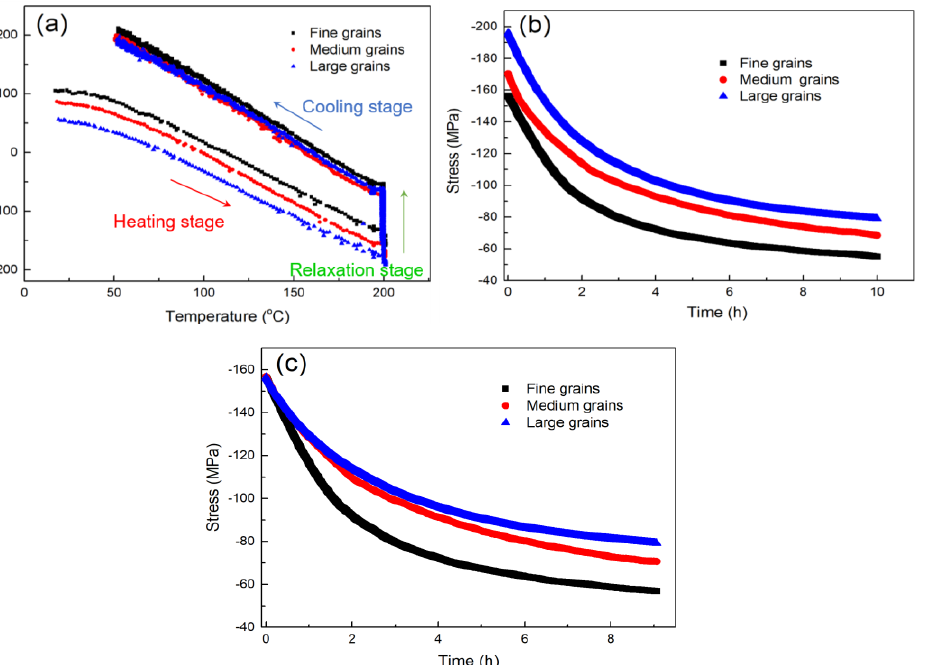
Figure 7. ( a ) Thermal-stress behaviors of the nt-Cu films with different degrees of (111) orientation. ( b ) Stress relaxation of the films with different degrees of (111) orientation. ( c ) Stress relaxation plotted from the same value of initial compressive stress at 200 °C. The nt-Cu films were electrodeposited at 35 °C. Table 5. Influence of grain size on the amount of stress relaxation.